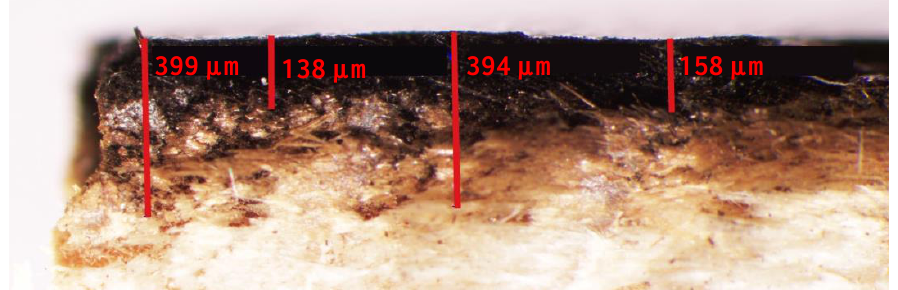
Figure 2. Microscope image example showing the approximate thickness of the char and thermally modified transition layers. Contrast enhanced to highlight char and transition layers.